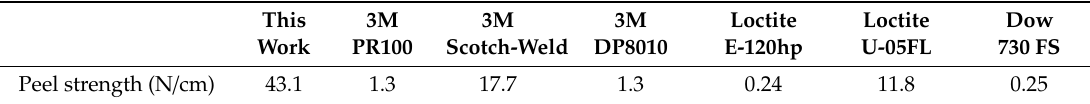
Table 1. Peel strength of the different adhesives on stainless steel.